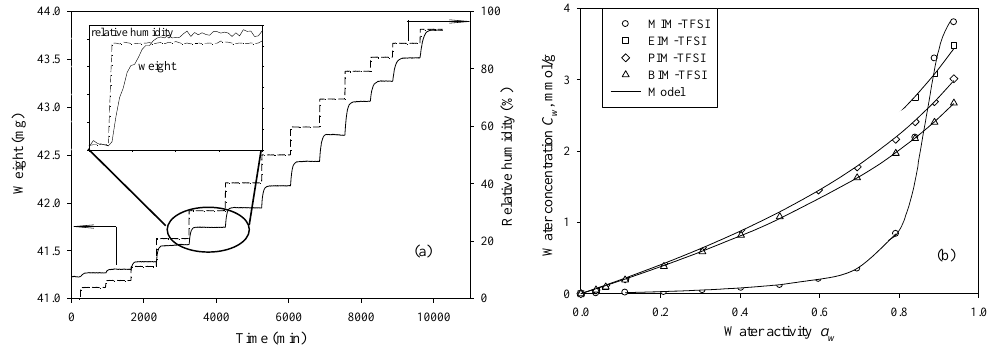
Figure 4. ( a ) Experimental sorption data and ( b ) water vapour sorption isotherms of studied PILs. The water vapour sorption isotherm data (the equilibrium water content C w ) were plotted against the RH reached (Figure 4b). As one can notice, the water molecules involved in the water sorption show a similar behaviour in all studied PILs, as all concentration isotherms are not-linear, i.e., the sorption isotherm demonstrates the concurrent increase in the C w value with the increase in the RH value (Figure 4b). A non-uniform distribution of sorption site energies across the material surface generally causes a non-linear isotherms shape. In our case the isotherm in the form of exponential shaped curve reflects Type III, according to the BET classification isotherms characteristics [48].